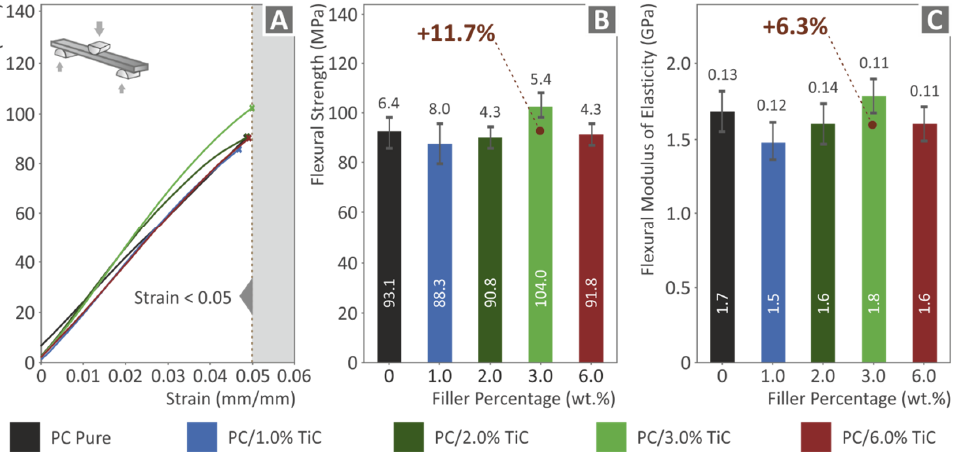
Figure 10. Flexural tests of all materials tested: ( A ) stress vs. strain graphs up to 5% strain following the standard, ( B ) mean flexural strength and deviation at 5% strain, and ( C ) mean flexural modulus of elasticity and deviation at 5% strain.